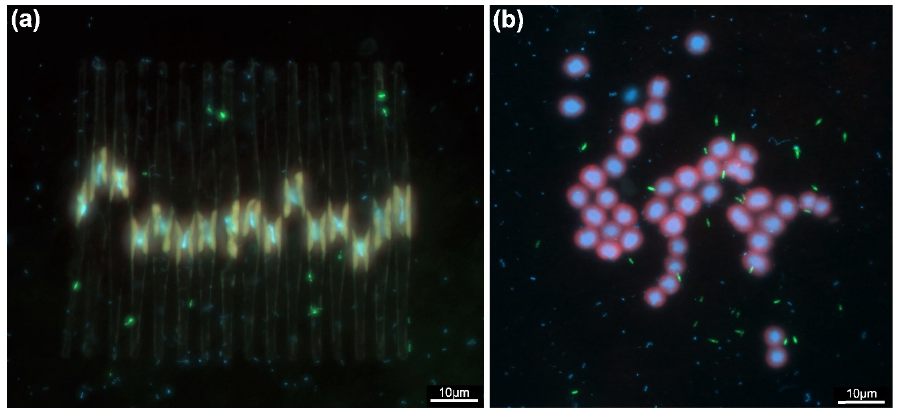
Figure 8. CARD-FISH images showing association of Gemmatimonadetes cells with colony of ( a ) Fragilaria sp. and ( b ) Microcystis sp. The signal of the probe is shown in green, DAPI staining in blue and autofluorescence in red. The photographs were taken by dr. Tanja Shabarova from Institute of Hydrobiology, Biology Centre of the Czech Academy of Sciences. Figure was adapted from ref. [18]. Sequences from BD2-11 terrestrial group, were reported in sediments of Siberian soda lakes [95]. In addition, MAGs containing phototrophic genes were recovered in soda lake sediments, including one that also contained genes encoding large subunit of Ru- BisCo [19]. Furthermore, in sediment samples of shallow hypersaline Tuz lake in Turkey,